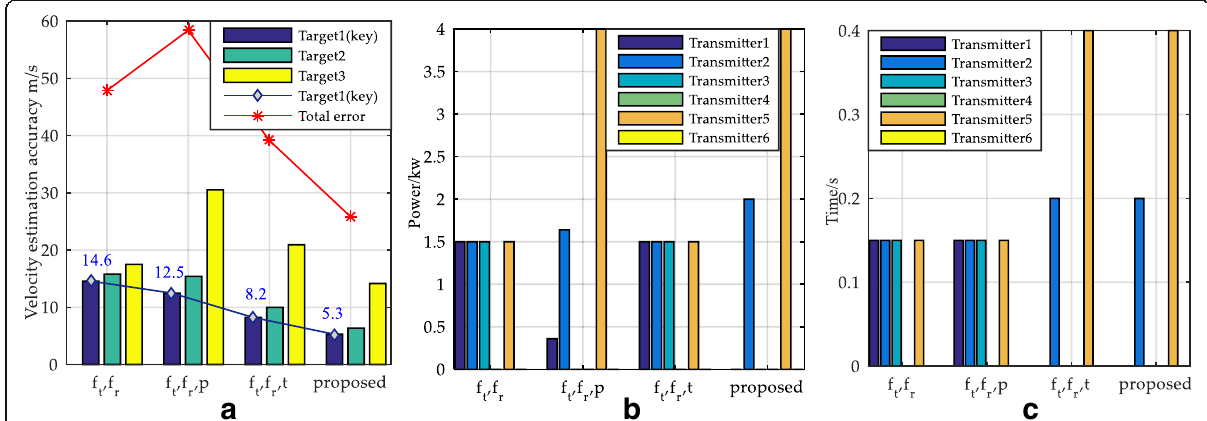
Fig. 2 Experimental results with MSE = [inf, inf , inf]m 2 /s 2 . a Velocity estimation accuracy. b Power allocation results. c Time allocation results